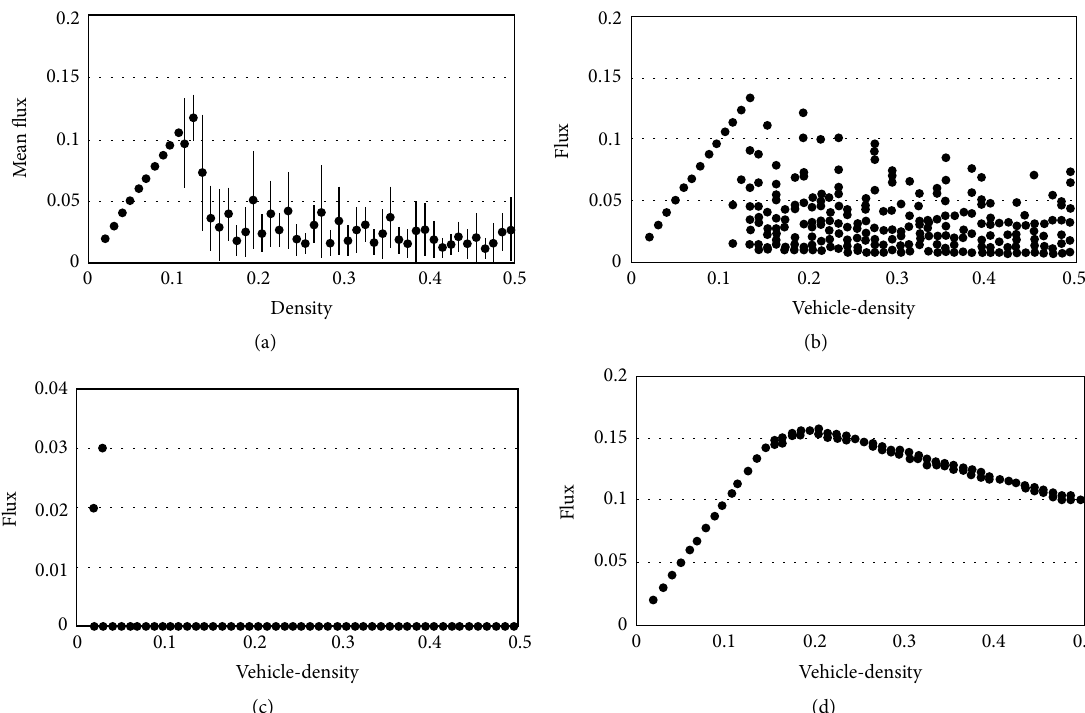
Figure 1: Relationship between flux and vehicle density. (a) Mean flux for the multi-state NS model with 𝑝 = 0.01 , v max = 5 , threshold_slow = 5, and threshold_acceleration = 15. The vertical bars indicate the standard deviation. (b) Fluxes from all trials for the multi-state NS model. (c) Fluxes from all trials for the calm model with 𝑝 = 0.01 , v max = 5 , and threshold_slow = 5. (d) Fluxes from all trials for the harsh model with 𝑝 = 0.01 , v max = 5 , and threshold_acceleration =